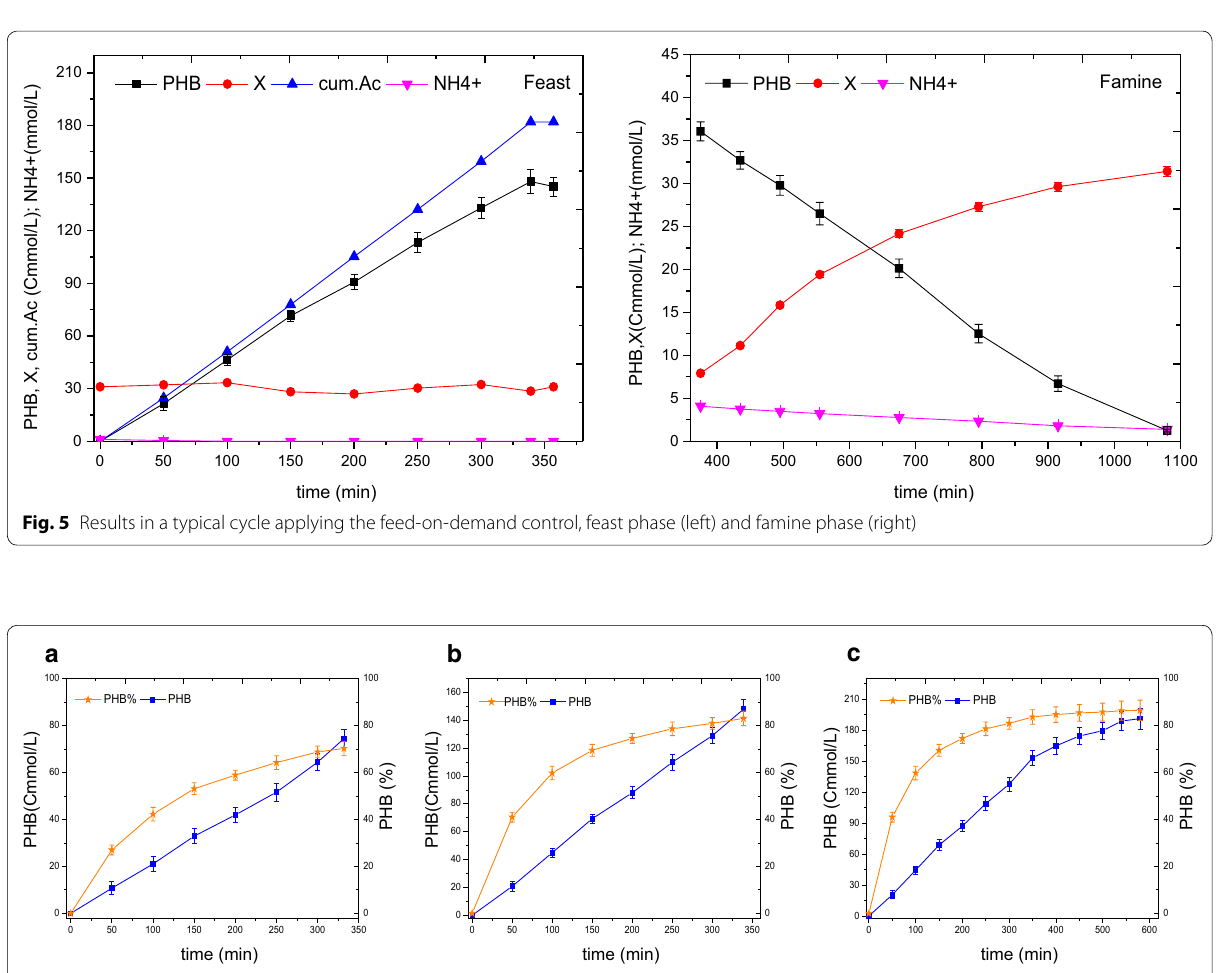
Fig. 6 PHB accumulating performance in SBR ( a ), FD ( b ) and batch ( c )